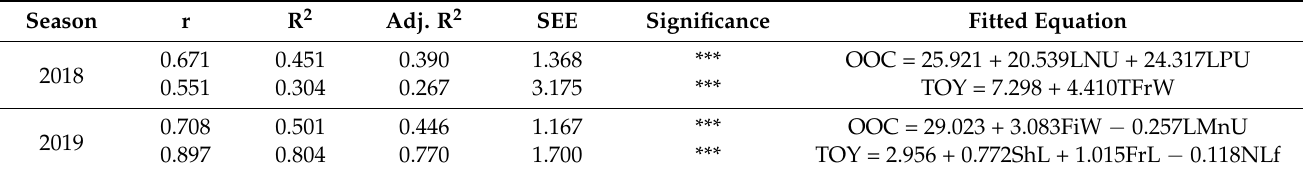
Table 7. Proportional contribution in predicting olive oil content (OOC) and total olive yield (TOY) using stepwise multiple linear regression for olive tree (Picual cv.) with three acidifying agents applied in two doses in comparison with untreated trees in 2018 and 2019 seasons. Adj. R 2 SEE Significance Fitted